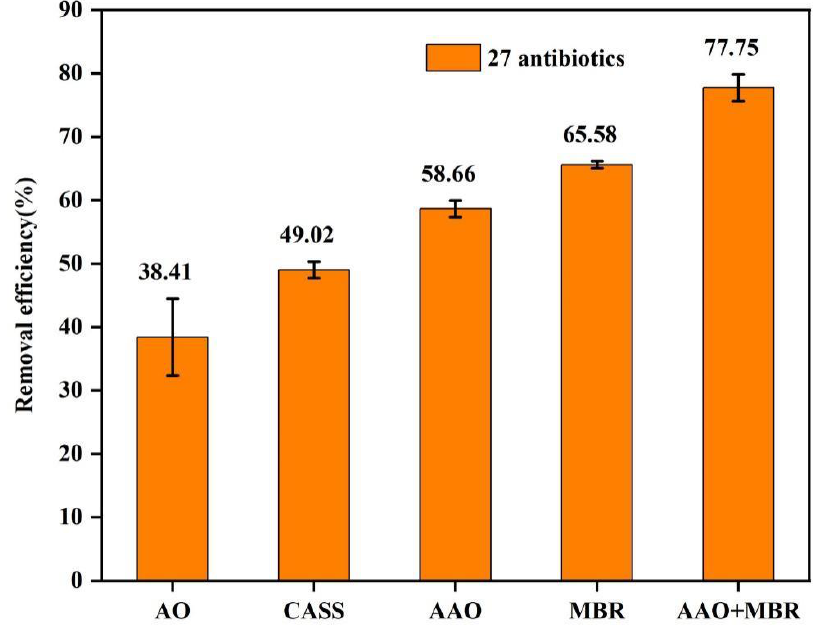
Figure 5. Mean removal efficiencies (%) of antibiotics in pharmaceutical plants with different treat- ment processes (Abbreviations: AO: anaerobic/aerobic; CASS: conventional activated sludge sys- tem; AAO: anaerobic/anoxic/aerobic; MBR: membrane bioreactor; and AAO + MBR: anaerobic/an- oxic/aerobic and membrane bioreactor).